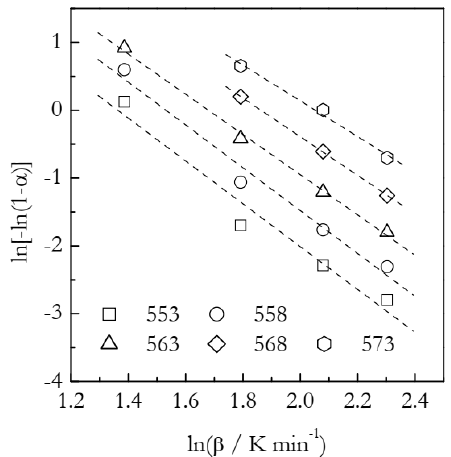
Figure 8. Ozawa plots for cyanate ester polymerization. Numbers by the symbols are temperatures in K. Dash lines are least square fits to respective points. Table 3. The Ozawa–Avrami model parameters for the cyanate ester data.